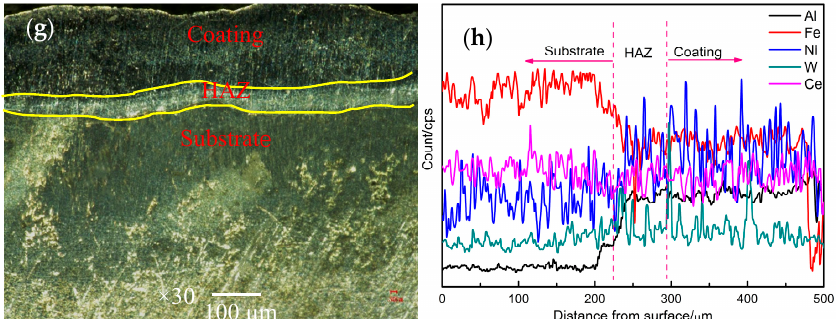
Figure 4. Cross section morphology ( a , c , e , g ) and linear scanning diagram ( b , d , f , h ) of coatings with di ff erent CeO 2 content: ( a , b ) 0.0% CeO 2 , ( c , d ) 1.0% CeO 2 , ( e , f ) 1.5% CeO 2 , and ( g , h ) 2.0% CeO 2 .